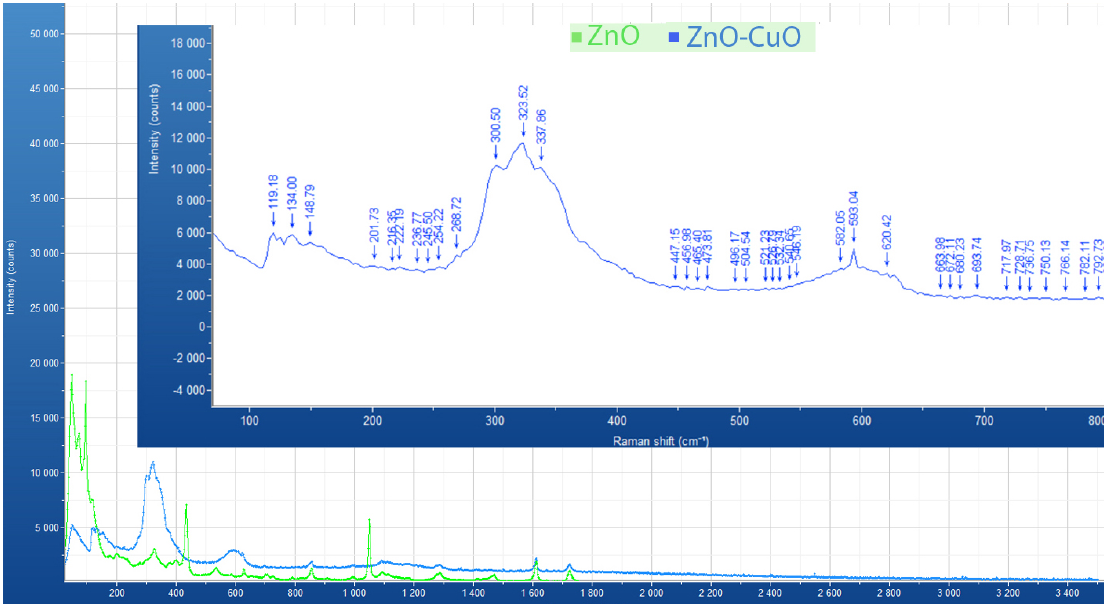
Figure 4. Raman spectra of pure ZnO (green line) and ZnO/CuO composite (blue line) nano-surfaces at room temperature. Conditions of recording the Raman Spectrum of the ZnO nano-surface: time acquisition 50 s, wavelength 785 nm. Conditions of recording the Raman Spectrum of mixed ZnO–CuO nano-surface: time acquisition 300 s, wavelength 785 nm. The inset shows a magnified view of the 100–800 cm − 1 section of the Raman spectra of ZnO/CuO composite (blue line)